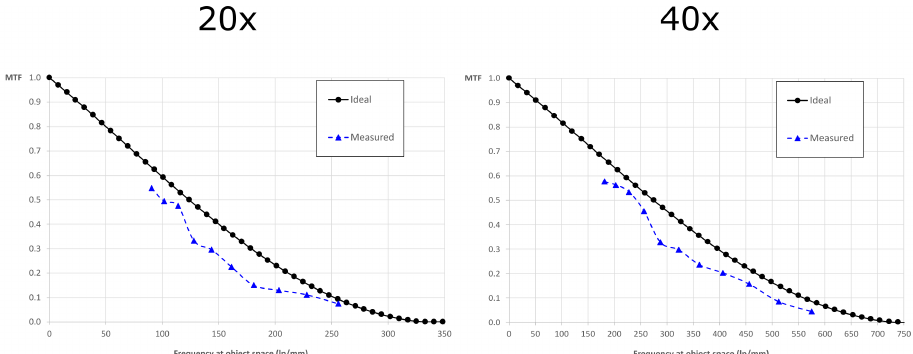
Figure 5. Extrinsic MTFs: the ideal and experimental MTF of the entire system when the lightfield eyepiece is coupled to the host microscope. On the left, the MTF with the 20x objective. On the right, the MTF with the 40x